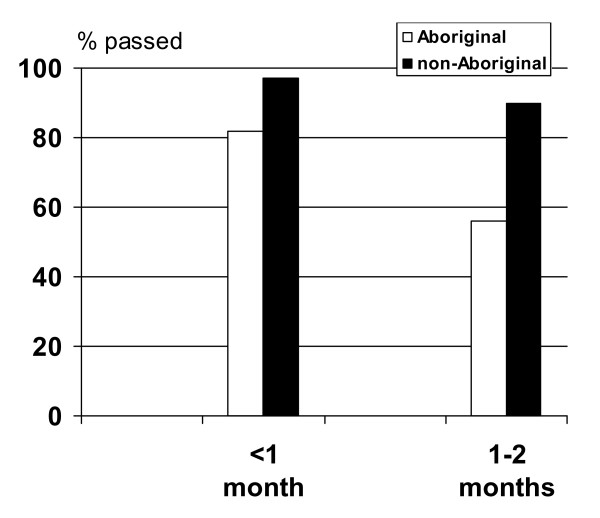
Proportion of Aboriginal and non-Aboriginal children with TEOAE responses present in both ears at ages <1 month and 1–2 months.